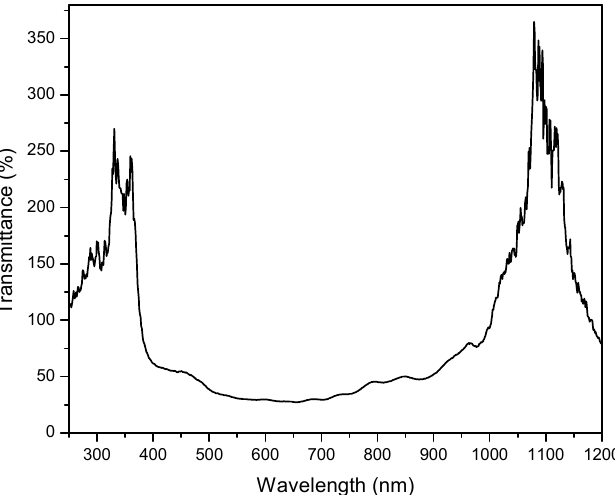
Figure 5. Initial spectral transmittance observed on the tested sensing structure under pure N 2 atmosphere; plotted values are relative to the continuous Au layer. Figure 6 shows absolute spectral changes in transmittance ( ∆ T abs = T NH3/N2 − T N2 ) under exposition to NH 3 /N 2 gas mixtures of different mass concentration. Apparently, a decrease in the transmittance is observed at the short- and long-wavelength limits of the scanned spectral interval. The observed transmittance drop is proportional to the ammonia gas concentration increase. At c ≈ 1000 ppm, a saturated state is achieved. The observed spectral regions of the most remarkable absolute transmittance changes clearly overlap with the spectral regions of the maximal transmittance of the tested structure (cf. Figures 5 and 6).